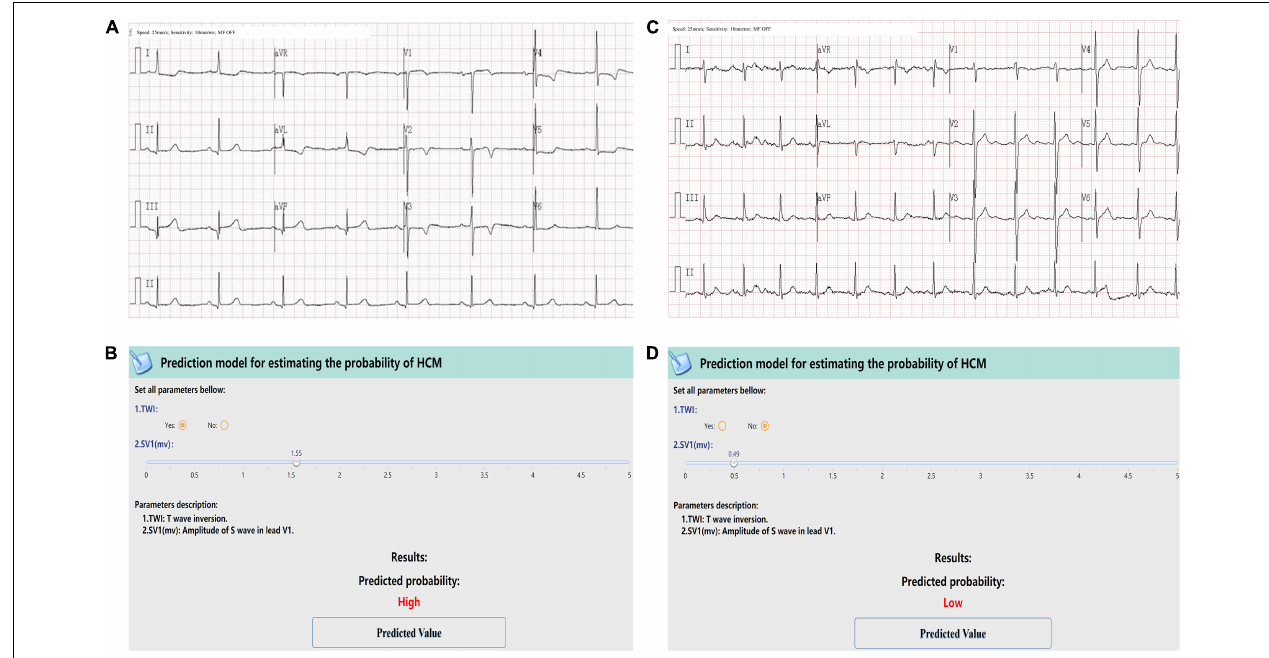
FIGURE 4 | Examples of the screen-shots of the web-based calculator. The first case was a 57-year-old male. ECG showed sinus rhythm, SV1 = 1.55 mV, and TWI in precordial leads V2 to V4. ECG showed no indications of LVH (A) . A screenshot of the web-based calculator indicated a high probability of HCM and recommended a referral to a dedicated HCM center. Then the patient was diagnosed as HCM, with an MWT of 23 mm and an LVOTG of 50 mmHg at rest by Echo (B) . The second case was a 35-year-female. Her ECG showed sinus rhythm with SV1 of 0.49 mV and no TWI (C) . She was classified as having a low probability of HCM by the model (D) . The echocardiography found no obvious abnormality, ruling out HCM.